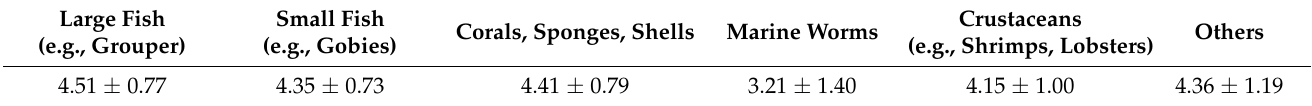
Table 2. Importance of the listed marine life to participants’ diving experiences. Large Fish